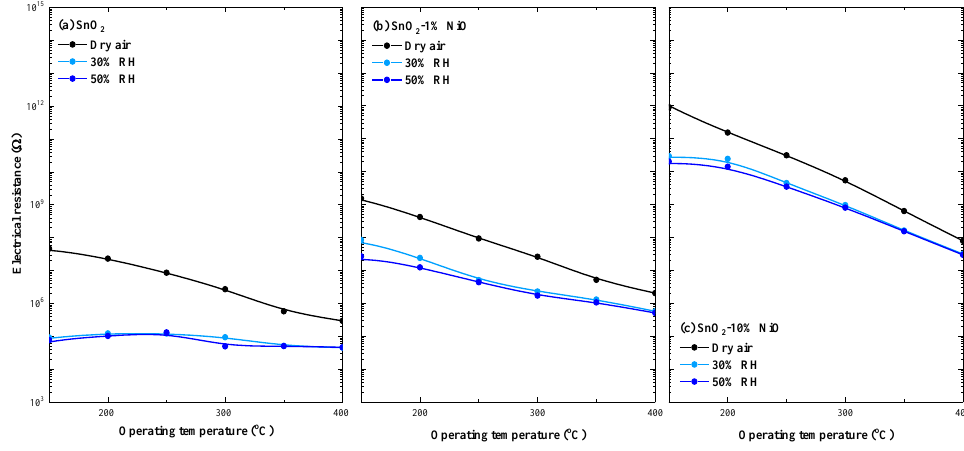
Figure 8. Humidity influences over the electrical resistance over a wide range of operating temper- atures for SnO 2 ( a ), SnO 2 -1%NiO ( b ) and SnO 2 -10%NiO ( c ). The doping level with a p-type MOX material (NiO) of the base n-type SnO 2 is reflected through its electrical resistance dependence with respect to the operating